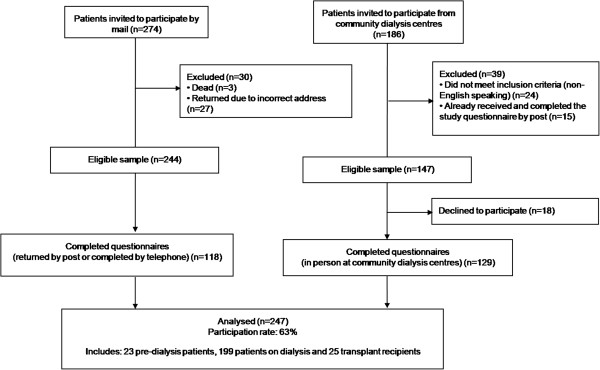
Flow of participants into the study.